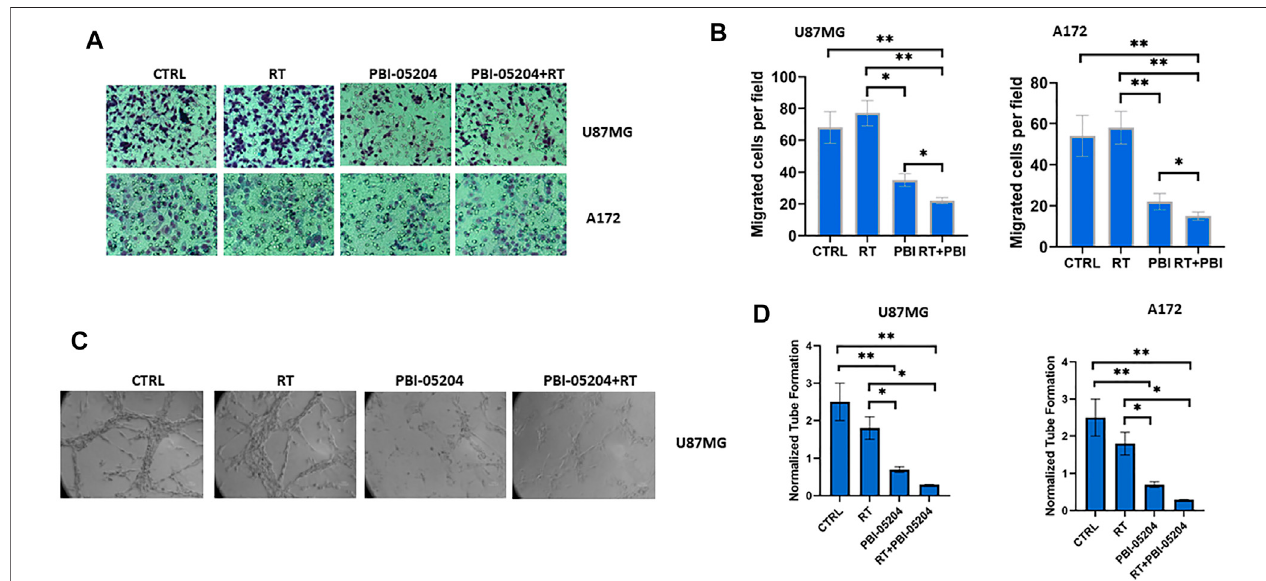
FIGURE 3 | PBI-05204 augmented the antimetastic and antiangiogenic potential of RT in U87MG and A172 cells. (A) Representative images of migrated U87MG and A172 cells. Cell motility through Matrigel-coated fi lters was measured 6 h after plating. (B) Quantitative analyses of the motility of U87MG and A172 cells after treatment with RT (4 Gy), PBI-05204 (5.0 μ g/ml) or RT plus PBI-05204. (C) Representative images of tubule formation of U87MG cells after treatment with RT, PBI- 05204 or RT plus PBI-05204 for 16 h. (D) Quantitative analysis of tubule formation in U87 and A172 cells. Data in (B , D) are presented as mean ± SD ( n = 4). * p < 0.05 and ** p <